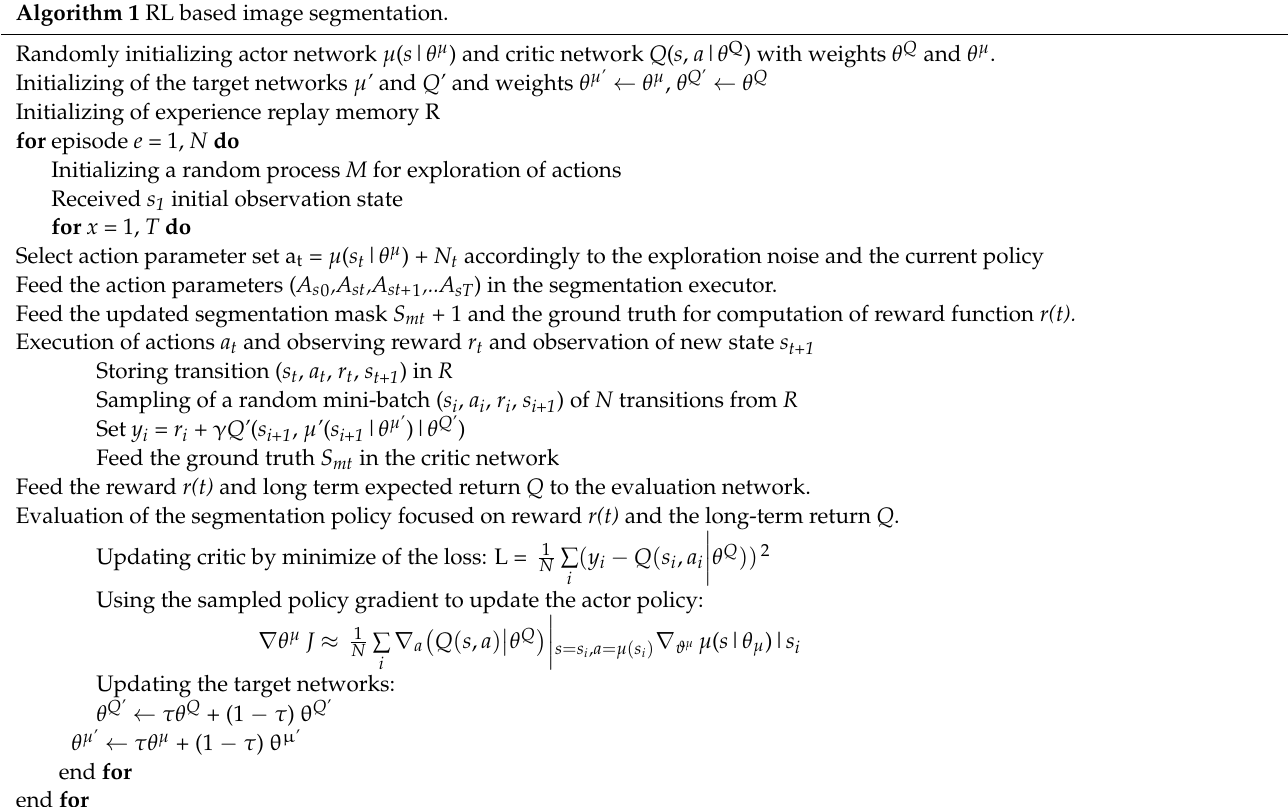
Algorithm 1 RL based image